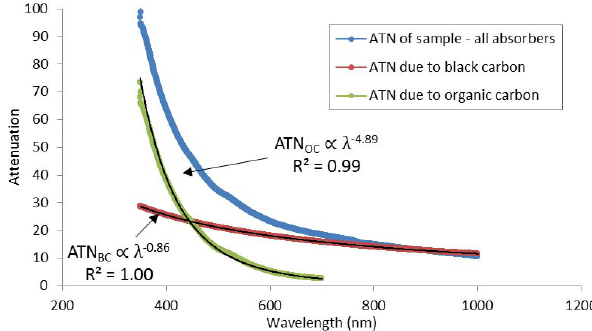
Fig. 1. Estimated contributions of black and organic carbon to the spectral attenuation of a residential wood smoke particulate matter sample. The exponents of the power law trend lines, 0.86 and 4.89, are the absorption Ångströmexponents of the black and organic carbon, respectively, for this sample.